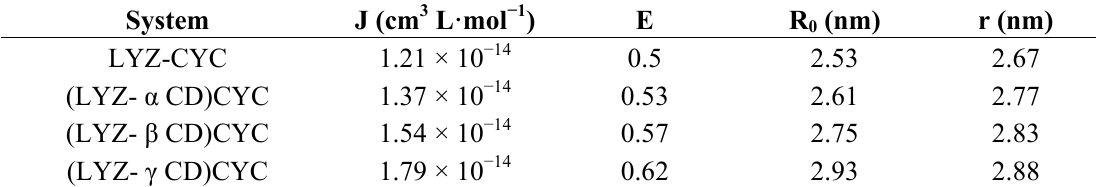
Table 4. The distance, r, between donor and acceptor of LYZ with CYC and cyclo- dexterins as binary and ternary systems (pH = 7.4, T = 298